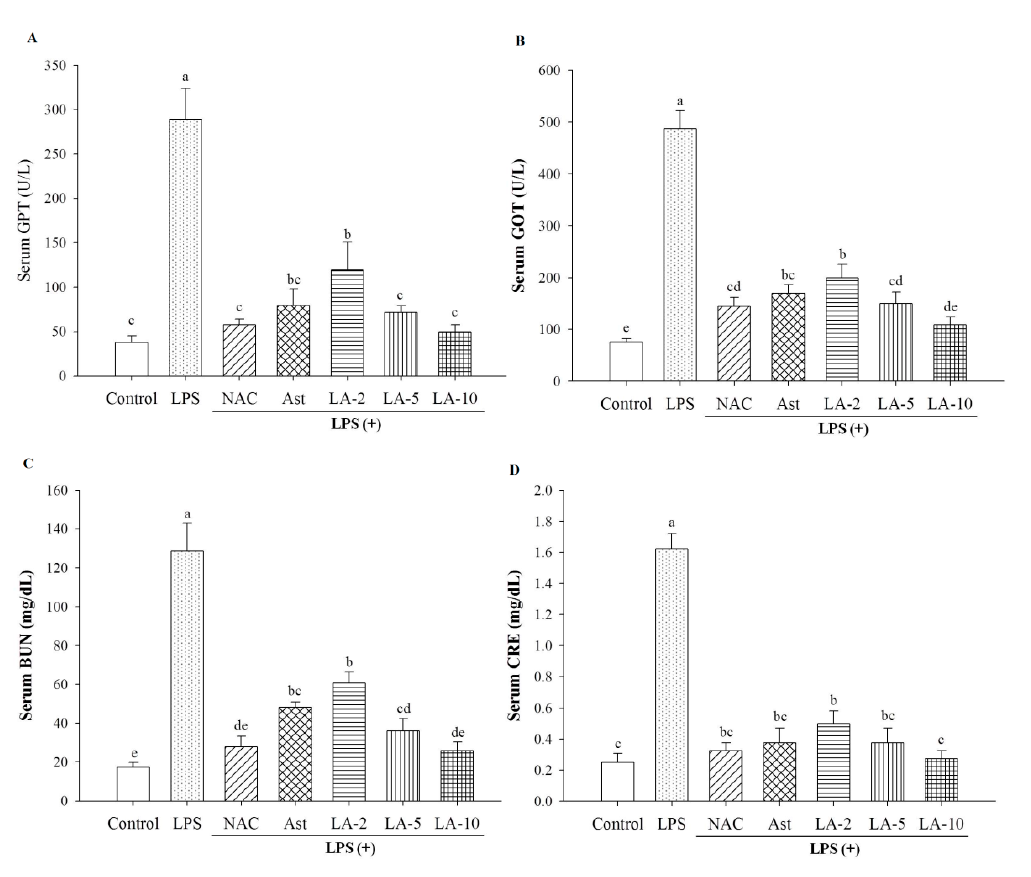
Figure 2. ( A ) Glutamate-pyruvate transaminase (GPT); ( B ) glutamate-oxaloacetate transaminase (GOT); ( C ) blood urea nitrogen (BUN) and ( D ) creatinine (CRE) levels in serum. Each bar represents the